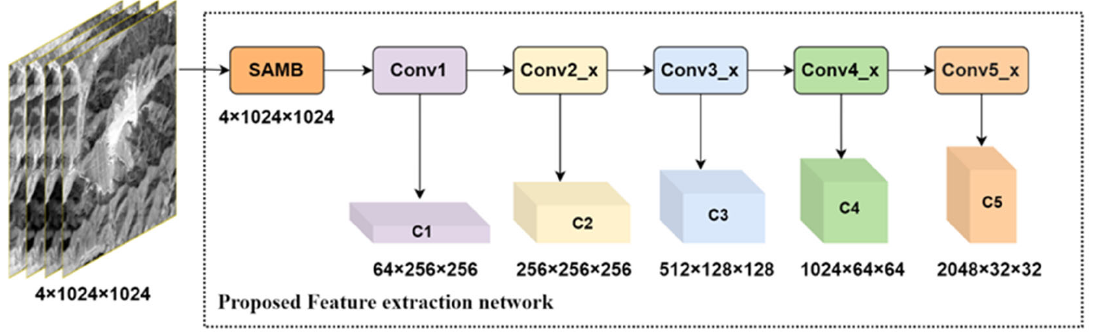
Figure 5. Proposed feature extraction network.